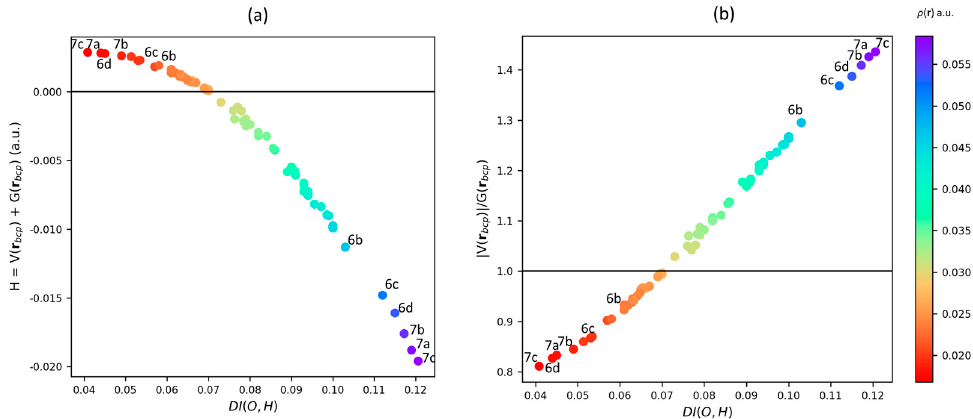
Figure 6. ( a ) Relationship between 𝐻(𝐫 𝑩𝑪𝑷 ) (a.u.) with the H···O a DI (a.u.) and ( b ) Relationship be- tween |𝑉(𝐫 𝑩𝑪𝑷 )|/𝐺(𝐫 𝑩𝑪𝑷 ) (a.u.) with the H···O a DI. The color scale it related to the HB 𝜌(𝐫 𝑩𝑪𝑷 ) (a.u.).